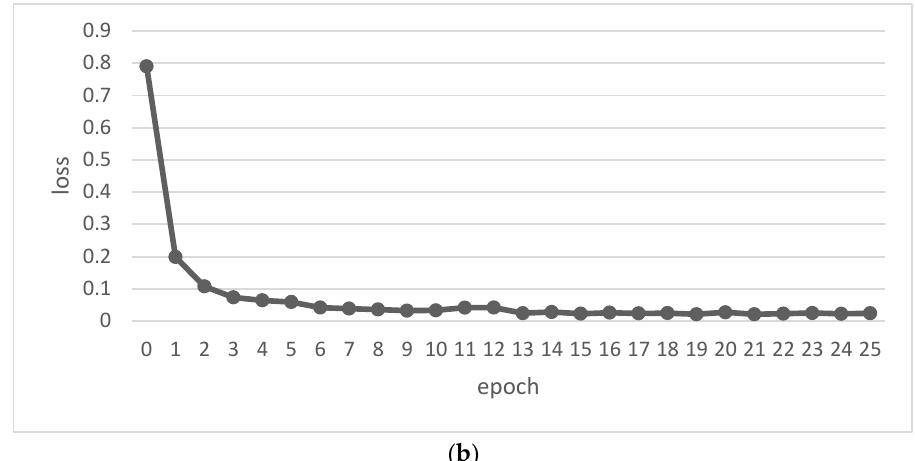
Figure 7. Model training results. ( a ) Accuracy curve, ( b ) Loss curve. Table 6. Comparison experiments.